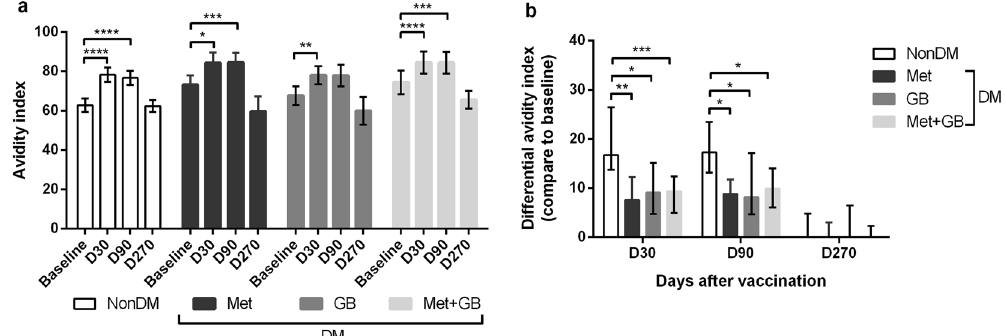
Figure 2. T2DM impaired the fold-change and differential avidity index of IgG. (a) The avidity index of influenza-specific IgG antibody at several time points or (b) differential avidity index of an influenza-specific IgG antibody response compared with baseline and D30 or D90 or D270 post-vaccination in all individuals. Statistical analyses were undertaken using two-way ANOVA. Horizontal lines represent ( a ) the mean with 95% CI or ( b ) the median with interquartile range. * p < 0.05; ** p < 0.01; *** p < 0.001; **** p <